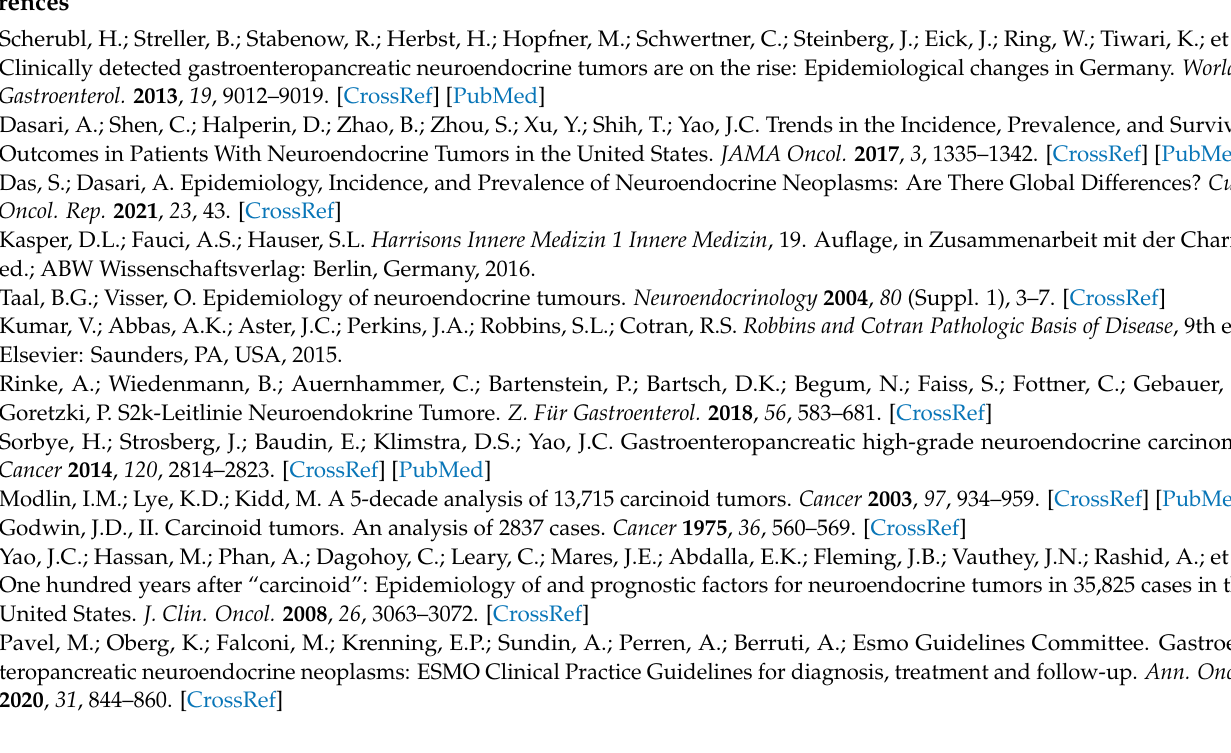
Figure S2: Progression-free (A) and overall (B) survival according to the modified Glasgow Prognostic Score (GPS) (log-rank mGPS 0 vs. mGPS 1 vs. mGPS 2; (A,B)). Table S1: Data on model fit and concordance of CRP and albumin-based risk scores in GEP NEN patients. Table S2: Second line treatment modalities of all GEP-NEN-patients included in the study. Table S3: Third line treatment modalities of all GEP-NEN patients included in the